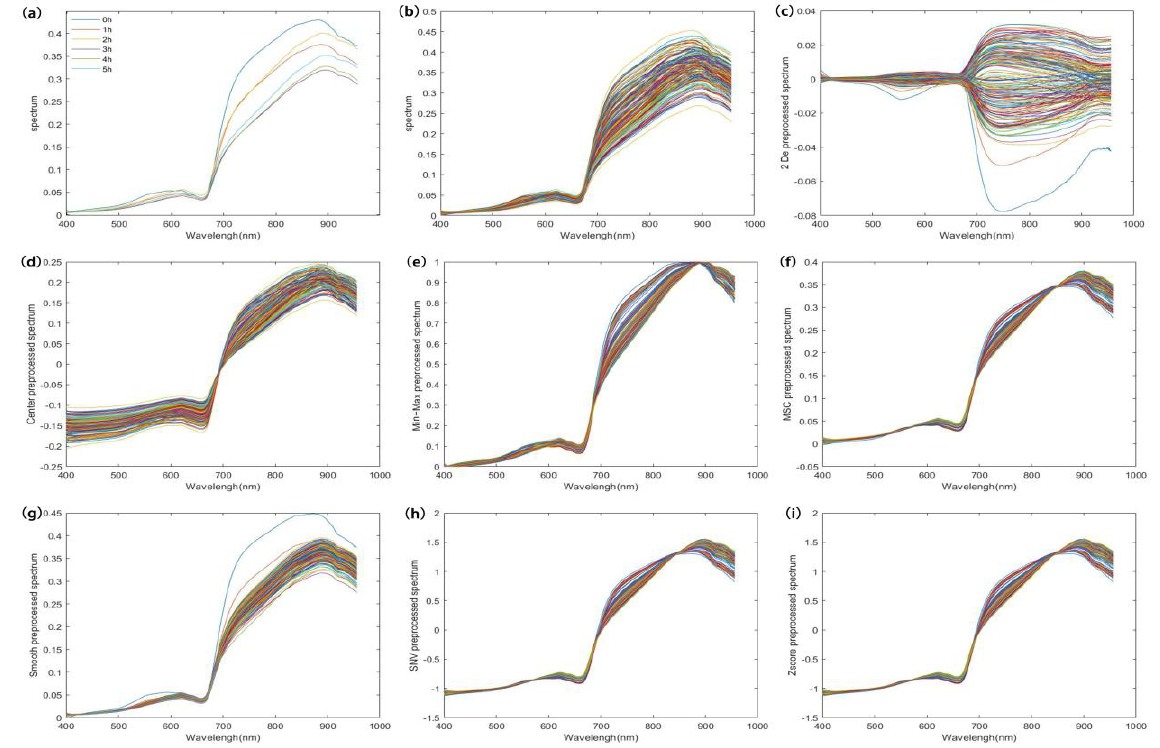
Figure 4. A set of average spectra at different fermentation moments and spectral curves before and after pretreatment. (( a ) is the average spectrum of black tea at different fermentation times; ( b ) is the original spectrum of black tea at different fermentation moments; ( c – i ) are the pre-processed spectra of the original spectra using 2 De, Center, Min-Max, MSC, Smooth, SNV, and Zscore algorithms, respectively). Table 2. Optimal results of pretreatment methods that affect catechin content, in the PLS model. Physical and Chemical